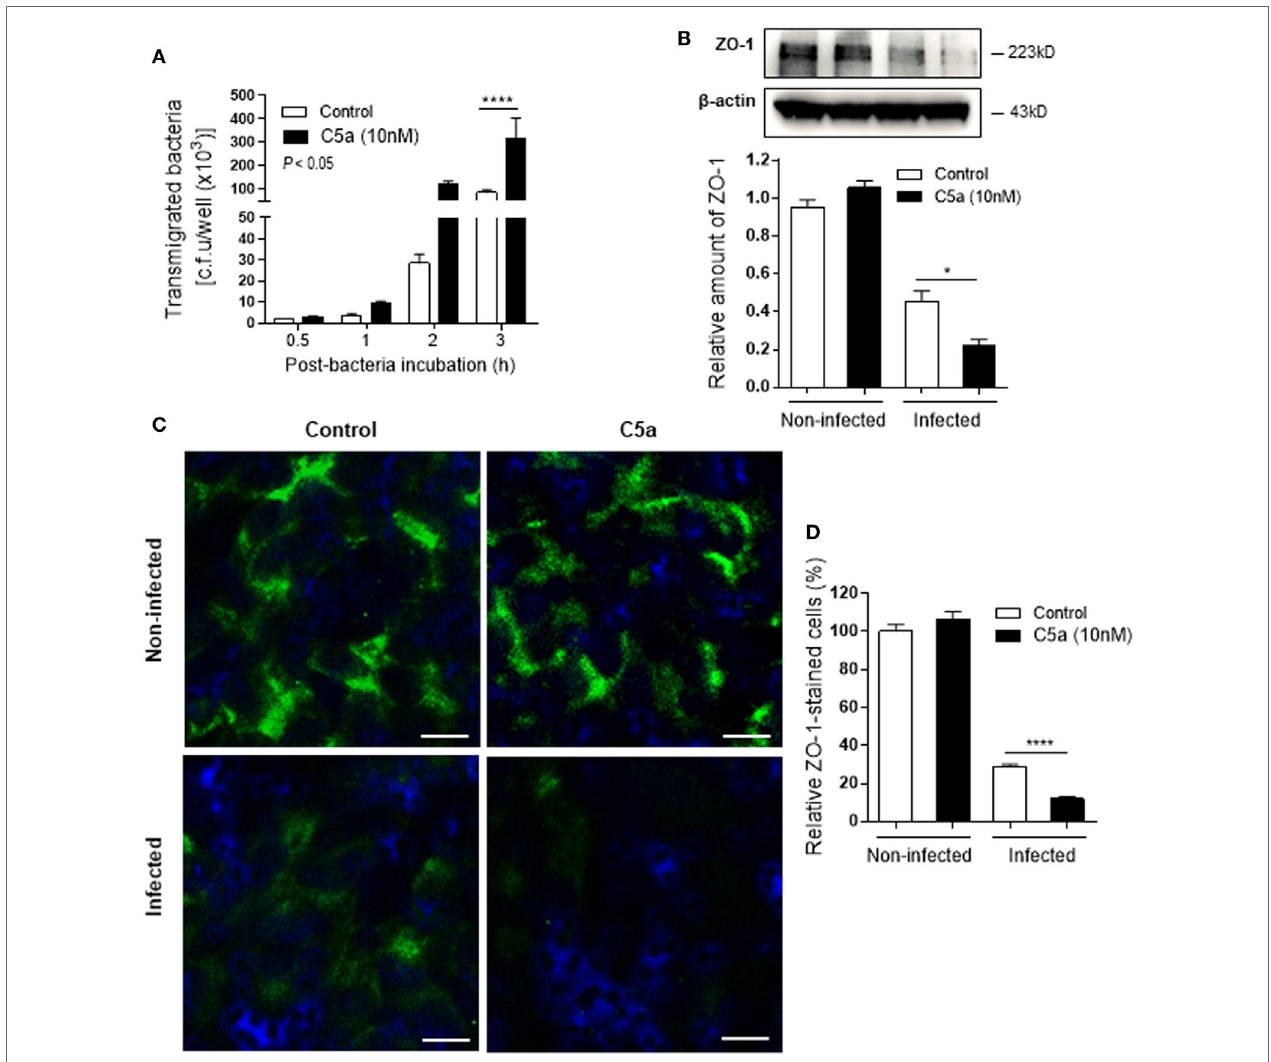
FigUre 3 | Effect of C5a stimulating renal tubular epithelial cell (RTEC) on bacterial transmigration through the monolayer of RTEC. Bacterial transmigration in RTEC that had been pre-treated with or without C5a (10 nM) for 24 h, then incubated with or without bacteria up to 3 h. (a) Transmigrated bacteria recovered from the lower chamber of RTEC cultures, evaluated by plate count assay. Data were analyzed by two-way ANOVA with multiple comparisons ( n = 4 individual wells per group). (B–D) Epithelial barrier damage, evaluated at 2 h after incubation with bacteria by reduction of tight junction marker ZO-1 expression. (B) Western blot analysis for ZO-1 in RTEC. Data were analyzed by unpaired two-tailed Student’s t -test ( n = 3 individual images per group). (c) Representative fluorescence images of ZO-1 (green) staining in RTEC. Scale bars, 10 µm. (D) Quantification of ZO-1-positive cells, shown as C5a treatment relative to control, corresponding to the RTEC shown in (c) . Data were analyzed by unpaired two-tailed Student’s t -test [ n = 4 individual images ( × 200 magnification) per group]. * P < 0.05, **** P < 0.0001. All results shown are representative of three independent